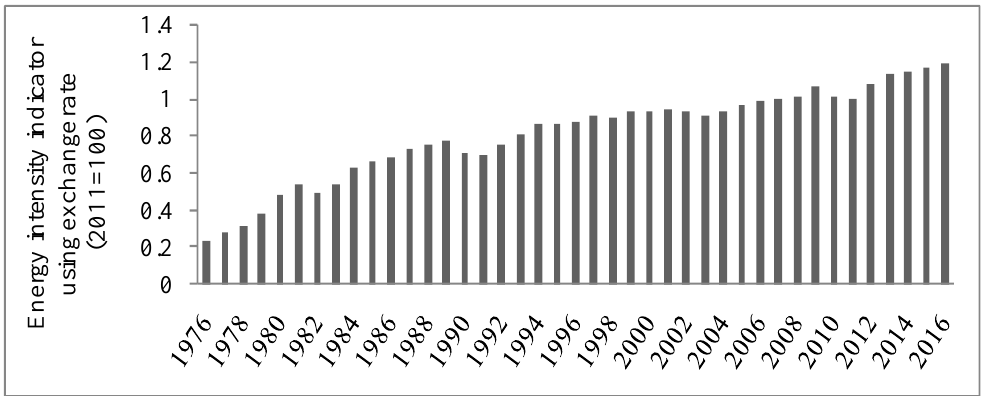
Figure 1. The trend of energy intensity in